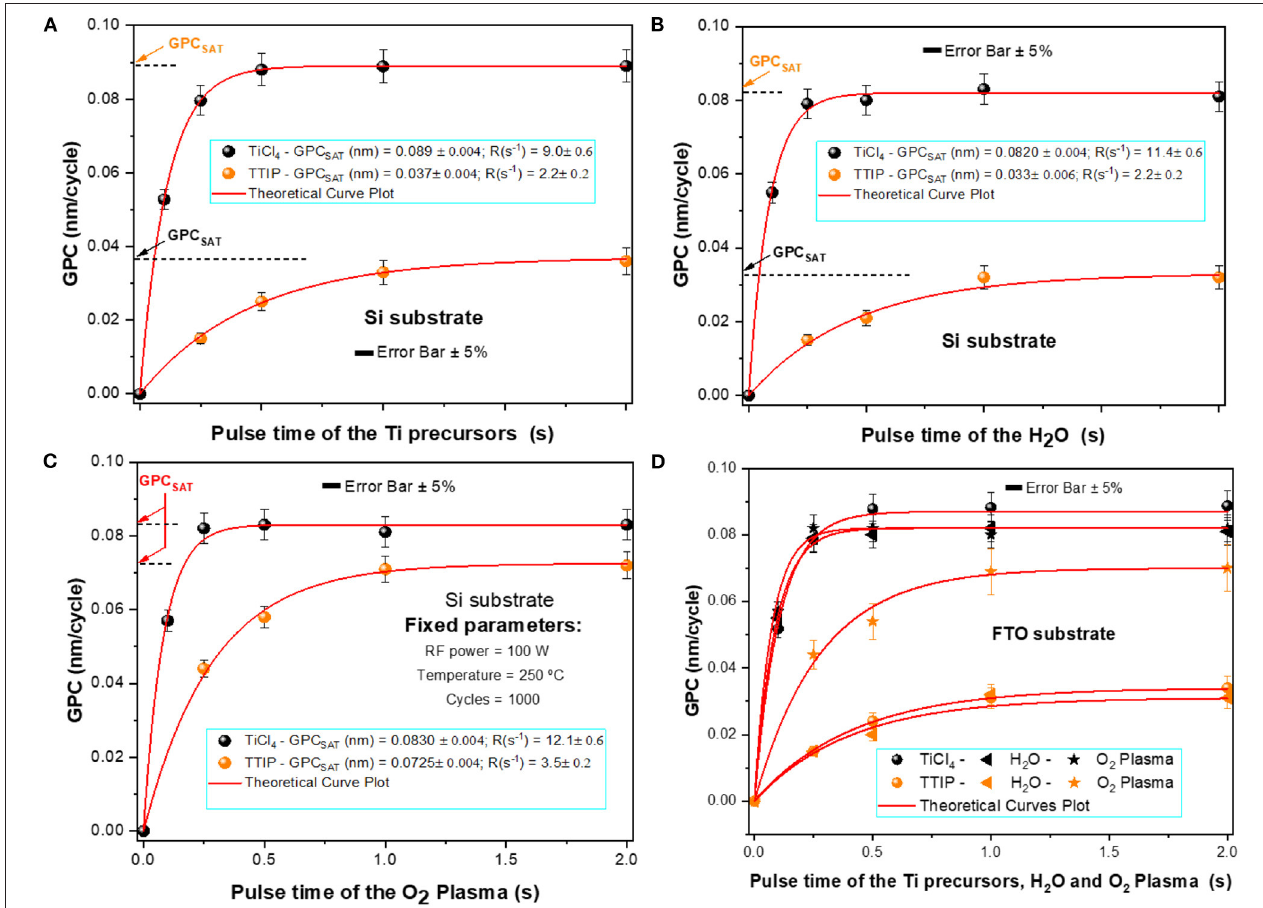
FIGURE 4 | Experimental, and simulated GPC vs. pulse time for TiO 2 thin films: (A) first and third set of samples on Si substrate, (B) second and fourth set of samples on Si substrate, (C) fifth and sixth set of samples on Si substrate, and (D) first to the sixth set of samples on FTO